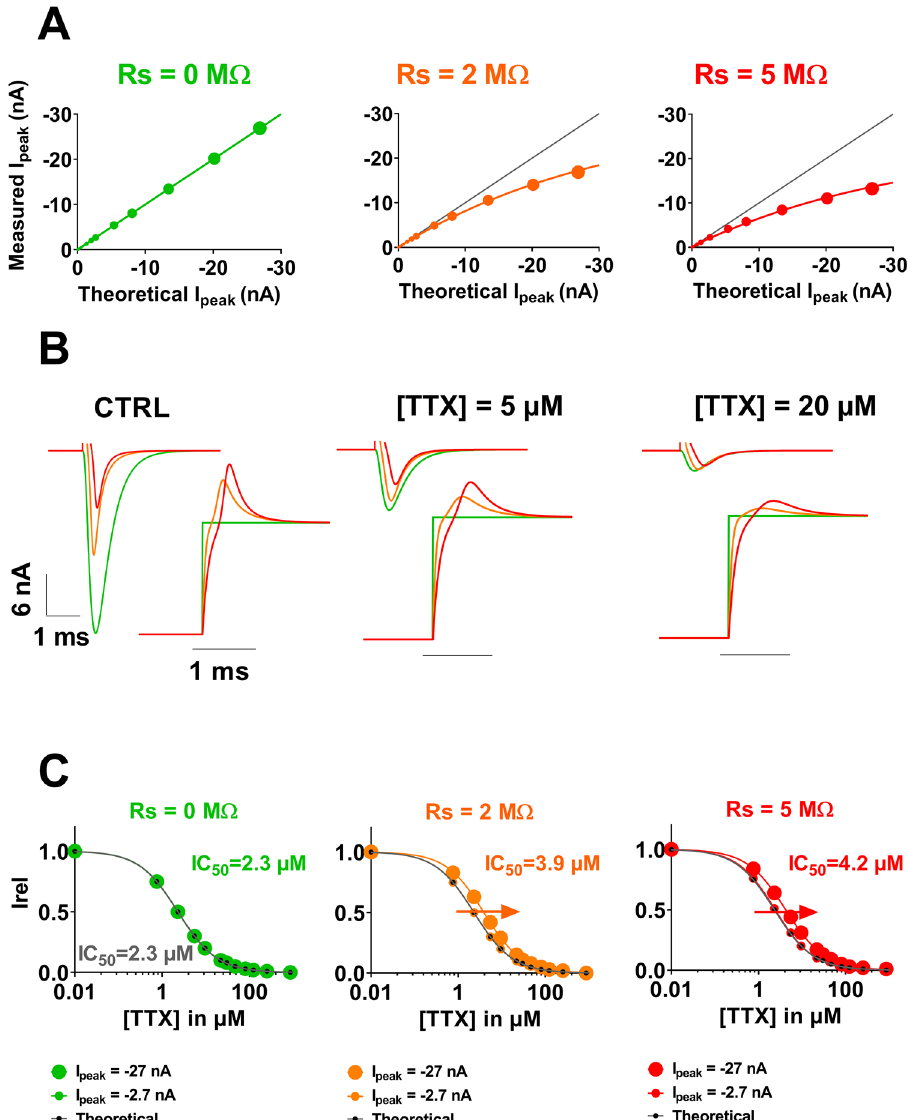
Figure 4. Kinetic model of cardiac I Na current (Na v 1.5)—computed effects of increasing series resistance and current amplitude on apparent TTX effects. (A) Relationships between the theoretical values of peak I Na (with no voltage error) and the measured values of I Na for three different values of R S (0, 2 and 5 MΩ). ( B) Computed recordings of the I Na current at the indicated TTX concentrations, for various values of Rs, as indicated by colors. ( C ) Computed dose–response curves for three R S conditions (R S = 0, 2 and 5 MΩ) and two amplitude ranges (I peak = − 2.7 and − 27